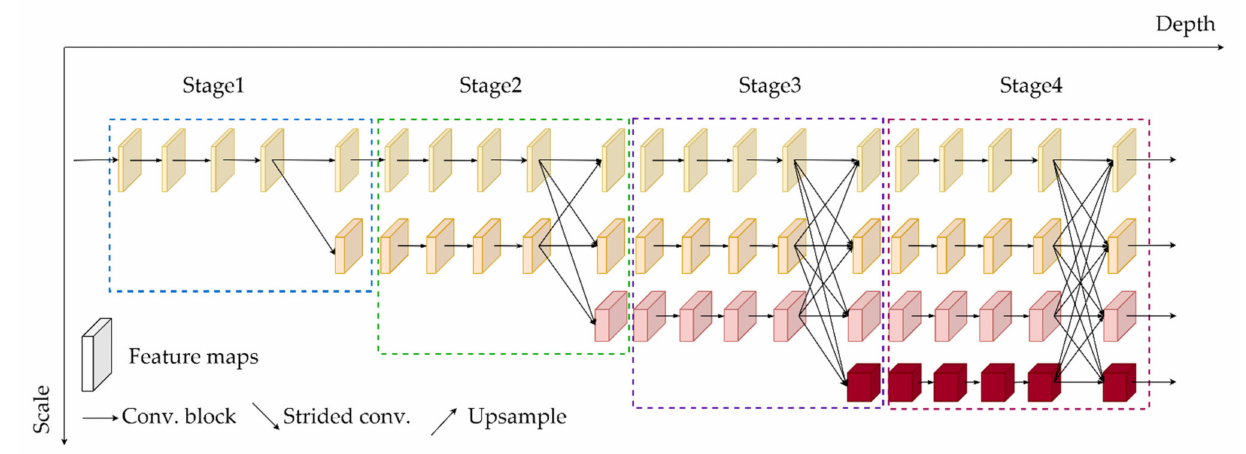
Figure 4. Schematic diagram of the HRNet network.